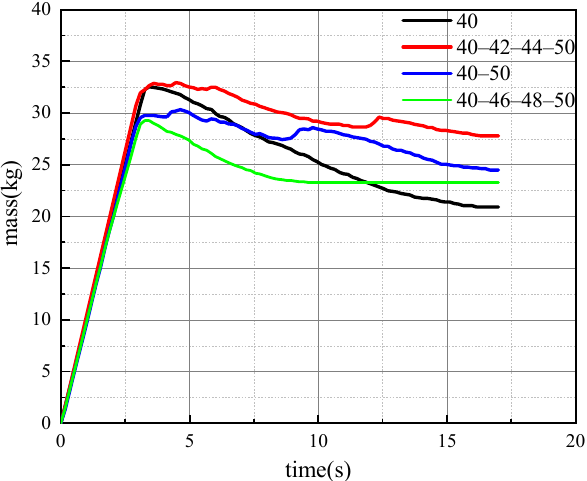
Figure 17. Blockage mass of particles with different particle size distributions in the first pump stage.